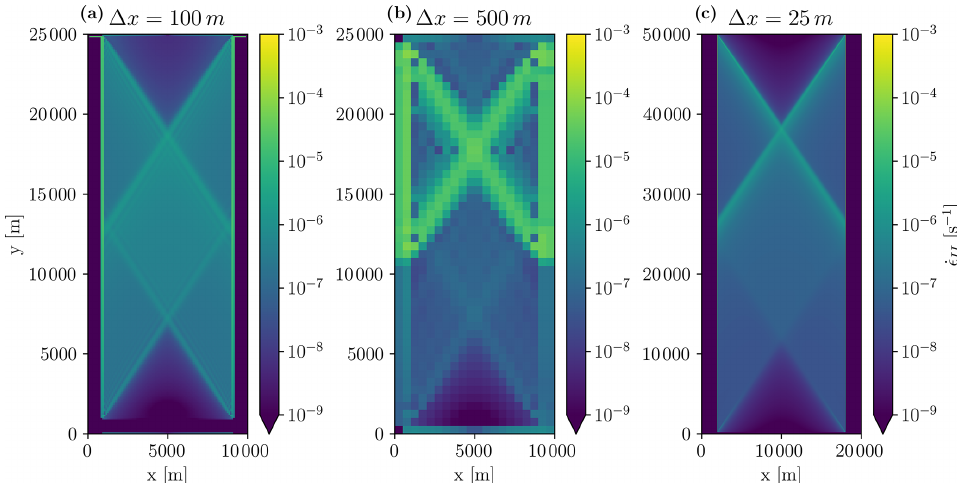
Figure 5. Maximum shear strain rate (second strain invariant) after 10s of integration for the default domain size and (cid:49)x = 100m (a) and 500m (b) and for the default (cid:49)x and a doubled domain size of 20km × 50km (c) . Note that for the case of the double domain (c) , the southward velocity at the northern boundary was also doubled to keep the deformation rate constant and that this simulation is limited to 2s for numerical efficiency.